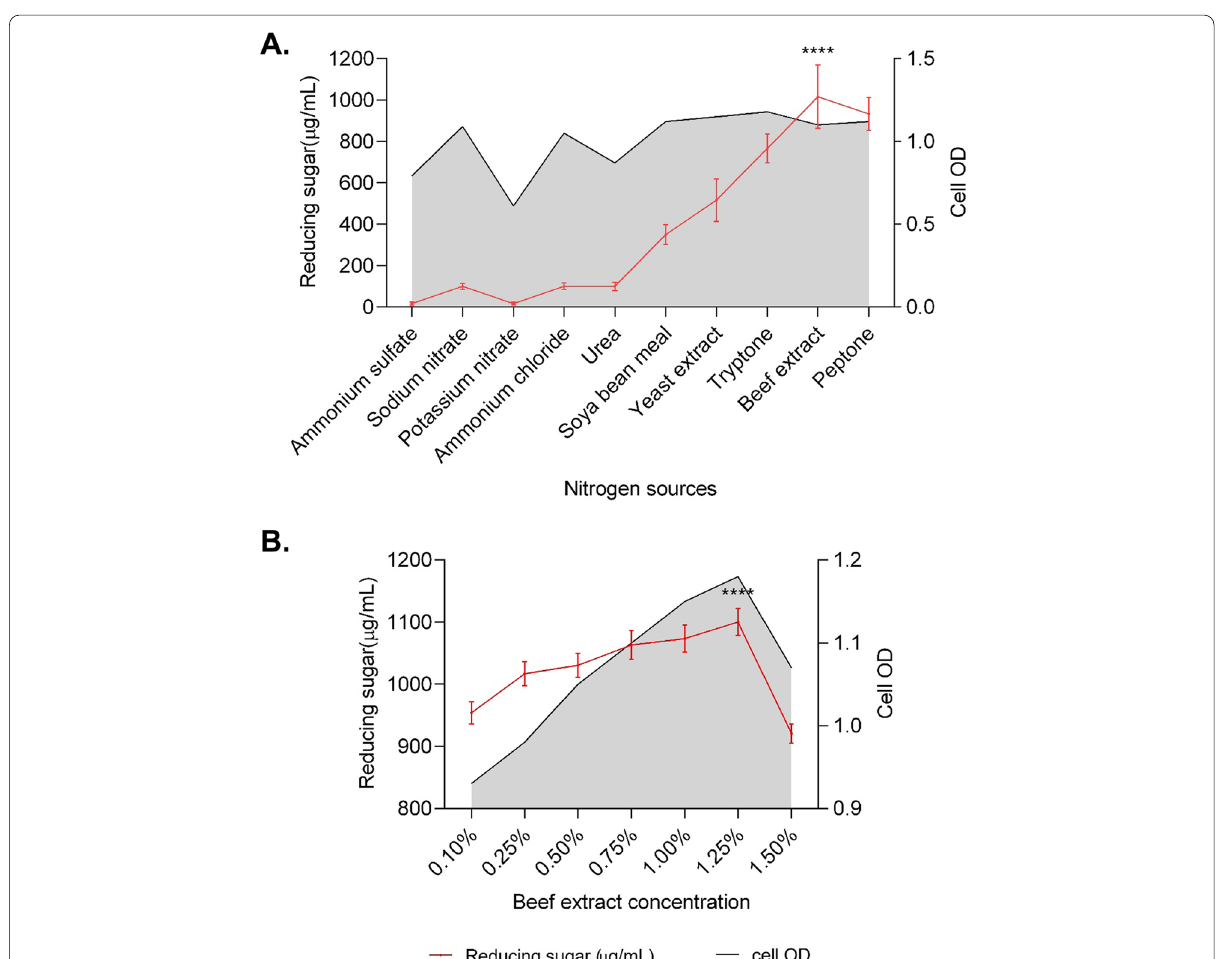
Fig. 4 Effect of A different nitrogen sources and B different concentrations of the beef extract on the production of reducing sugar and extracellular protein by Arthrobacter woluwensis TDS9. MS medium with 1.5% CMC as a sole carbon source and medium initial pH was 8. Incubation temperature and incubation time were 25°C and 72 h, respectively. Cell OD was measured at 600nm wavelength. **** indicates statistical significance value, P <